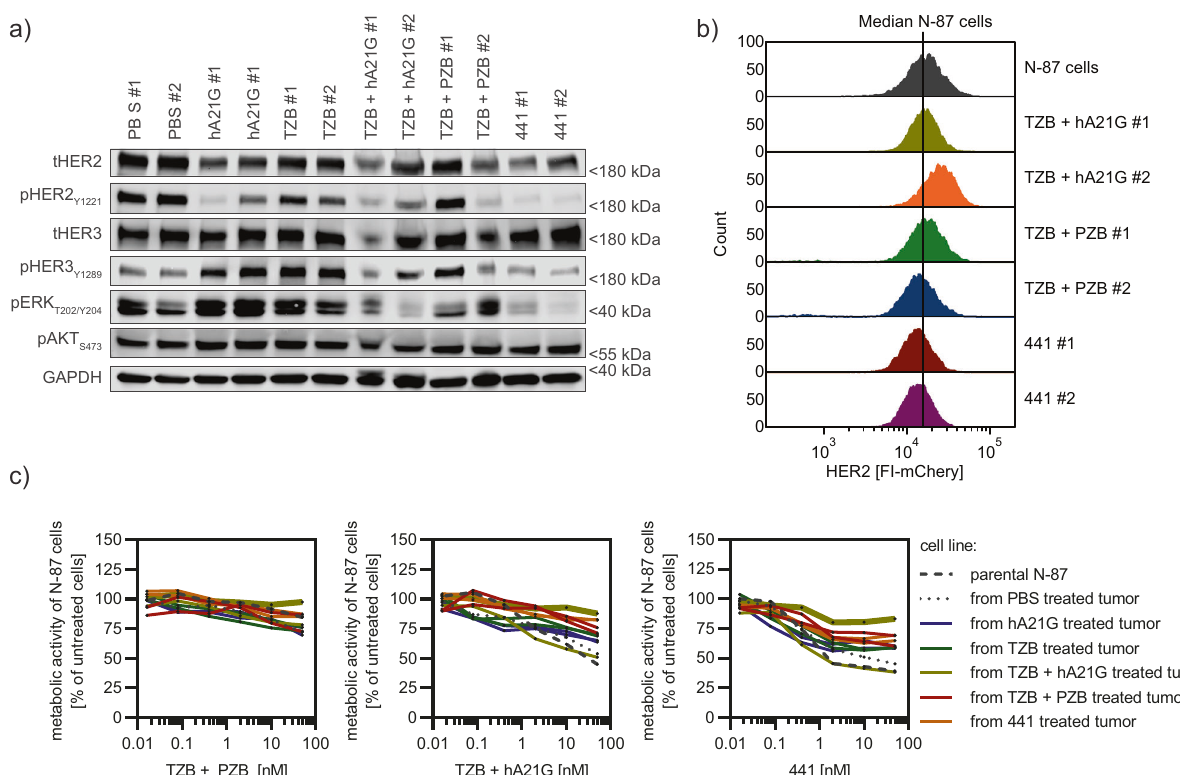
Fig. 9 441-treated tumors and derived cell lines show reduced HER2 expression, but remain responsive to anti-HER2 treatment. a Lysed xenograft tumors taken from the fi nal sacri fi ce, analyzed by immunoblotting, revealed severe reduction of total HER2 (tHER2), pHER2, pHER3, and pERK for 441- treated animals. mAb treatment-induced hyperphosphorylation of HER3 and ERK compared to PBS samples. mAb combinations revealed mixed responses. b Flow cytometric analysis of surface HER2 of cell lines established from mouse tumor material showed a loss of around 20% median intensity for 441- treated tumors. In contrast, HER2 levels stayed the same or were even augmented for TZB plus hA21G-treated animals. TZB and PZB induced a slight loss. c Cell lines derived from treated mouse tumors were challenged with indicated agents in a viability assay ( n = 3 biological replicates, mean plus error bar SD, connected points, no fi t). 441 was still able to reduce the proliferation the most among all studied agents. Tumors derived from 441-treated animals were also responsive to treatments; however, one TZB + hA21G-derived cell line had become practically resistant to treatments (thick dark-yellow line). Source data are available in the Source Data fi